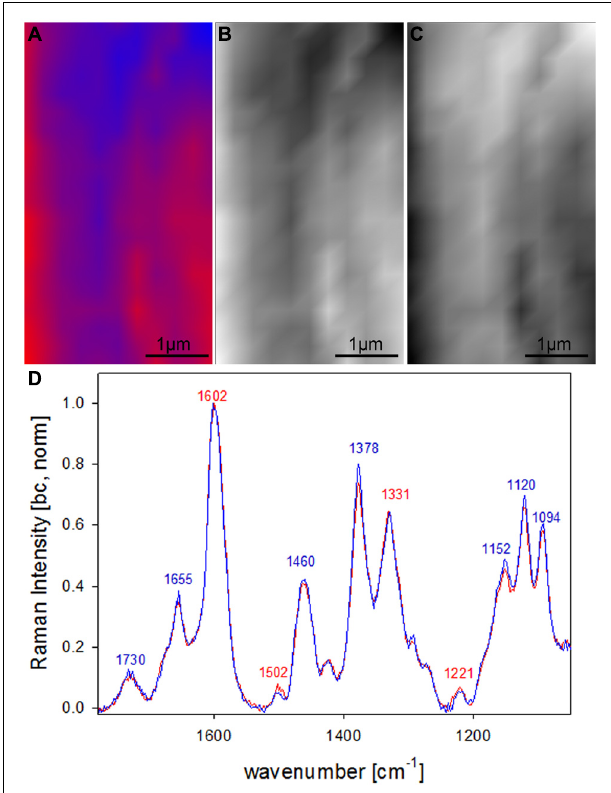
FIGURE 5 | Raman images of zoom into beech wood fiber secondary cell wall (4 μ m × 7 μ m) based on VCA analysis with two endmembers using the wavenumber region from 1800 to 300 cm − 1 : colored composite image visualizing a lamellar structure (A) and intensity changes of endmember 1 (EM1; B) and EM2 (C) and the corresponding EM spectra after baseline correction and normalization on the aromatic stretching vibration at 1599 cm − 1